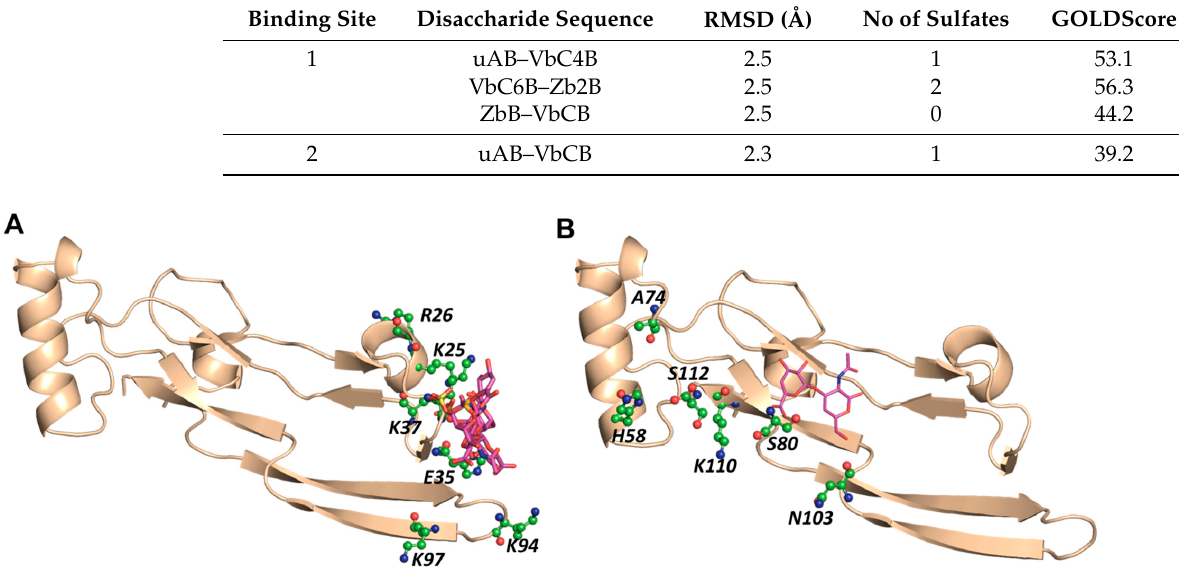
Figure 3. CVLS-predicted disaccharide sequences from the ∆ UA NRE , GlcA NRE , and GlcN NRE libraries of CS that prefer to bind to ( A ) BS1 and ( B ) BS2 of TGF- β 2 (magenta color by atom sticks). The disaccharides do not display favorable high interaction scores.